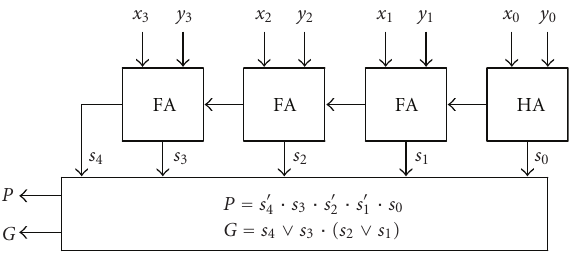
Figure 5: Ripple-Carry BCD adder cell.